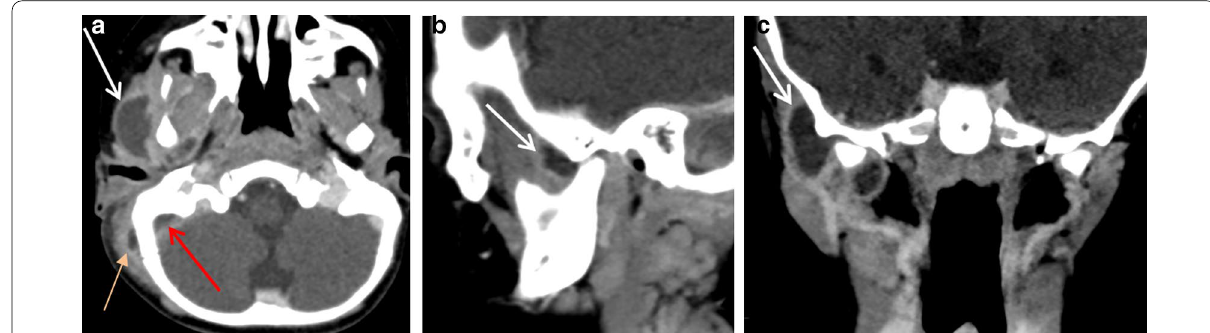
Fig. 23 Fusobacterium necrophorum infection. Right otomastoiditis complicated by subperiosteal abscess [orange arrow], sigmoid sinus thrombosis [red arrow] and temporomandibular arthritis [white arrow] leading to cheek swelling, on axial, parasagittal and frontal CT images, after intravenous injection of contrast medium ( a , b and c )